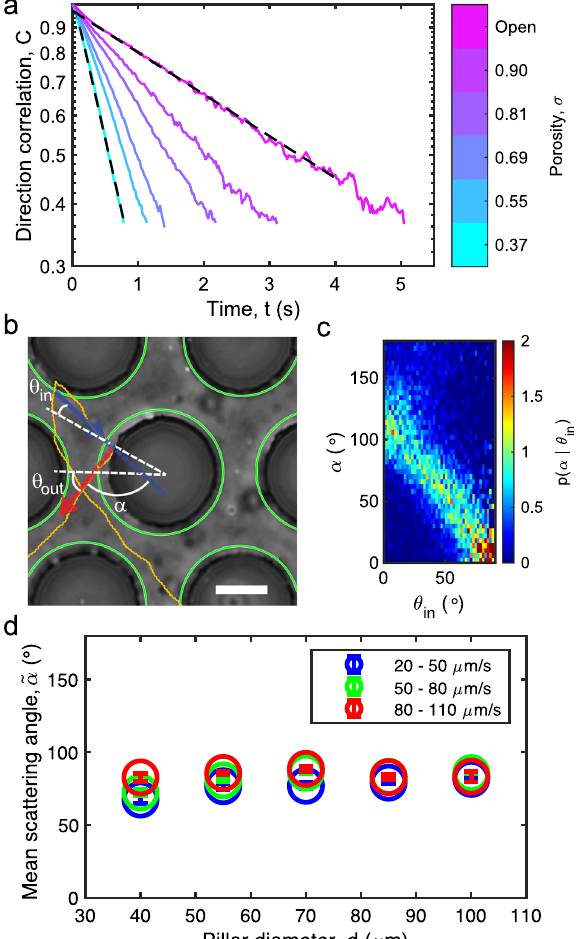
Fig. 2 Cell swimming direction decorrelates due to scattering from pillar surfaces. a Swimming direction correlation functions (see “ Methods ” ), C ( t ), for cells in a hexagonal lattice (scale, s = 1) exhibit an exponential decay across a range of porosities (0.37 ≤ σ ≤ 1). Dashed black lines show example fi ts to C ð t Þ ¼ e (cid:3) t = τ p . b Yellow dotted line shows a sample cell trajectory with several scattering events from nearby pillars. The blue vector indicates the measured cell orientation upon entering the impact area (green circle) of the central pillar with an incident angle ( θ in ) relative to the surface normal (white dashed line). The red vector indicates the cell orientation upon exiting the impact area with an outgoing angle ( θ out ). The cell orientation changes by a scattering angle in the range 0 ∘ ≤ α ≤ 180 ∘ . c Conditional probability, p ( α ∣ θ in ), of cell scattering angle given the incident swimming angle measured in a hexagonal lattice ( σ = 0.37, s = 1). d Ensemble mean cell scattering angles, ~ α , measured directly for various pillar diameters, d , and swimming speed ranges. Error bars show standard error of mean scattering